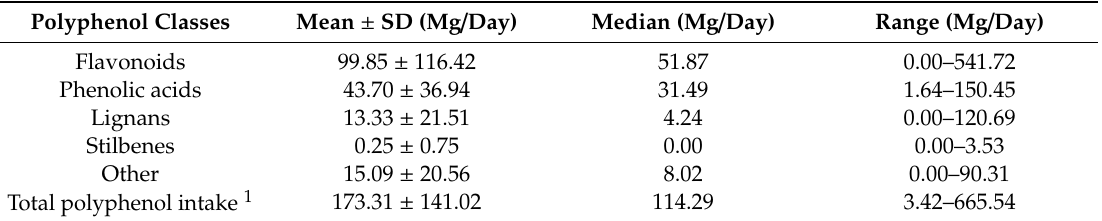
Table 2. Intakes of di ff erent classes of polyphenols and total polyphenol